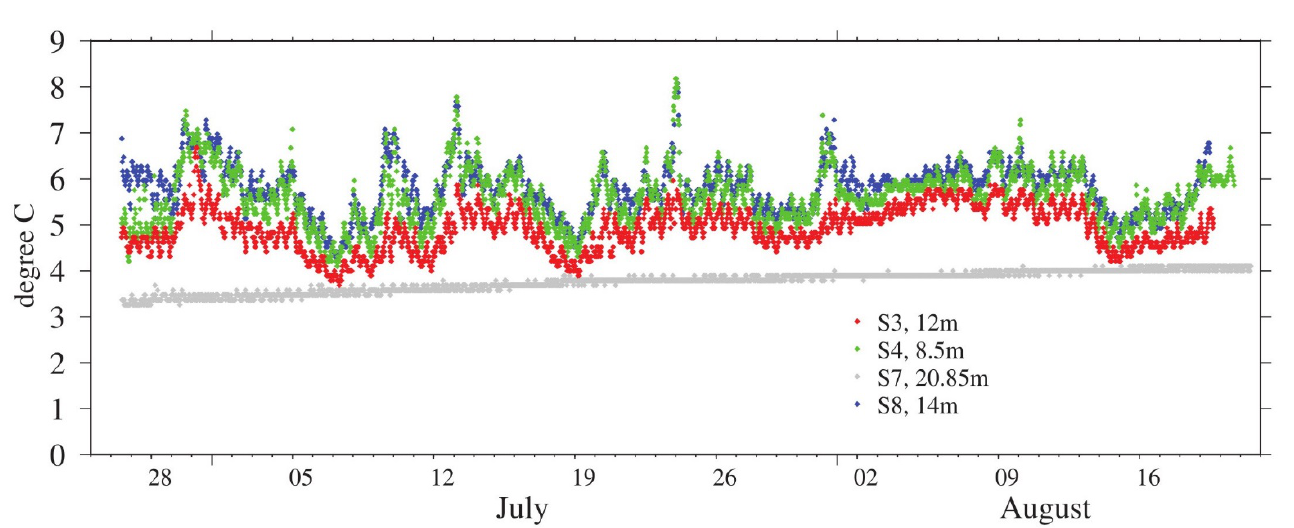
Figure 8. ( a ) CTD profiles (C24 and C25) from south of the Arsuk Island in Figure 1, ( b ) CTD profiles (C21 and C40) in outer Ikka Fjord in Figure 1, and ( c ) all CTD profiles in the inner part of Ikka Fjord with temperatures marked in blue and salinities in black.